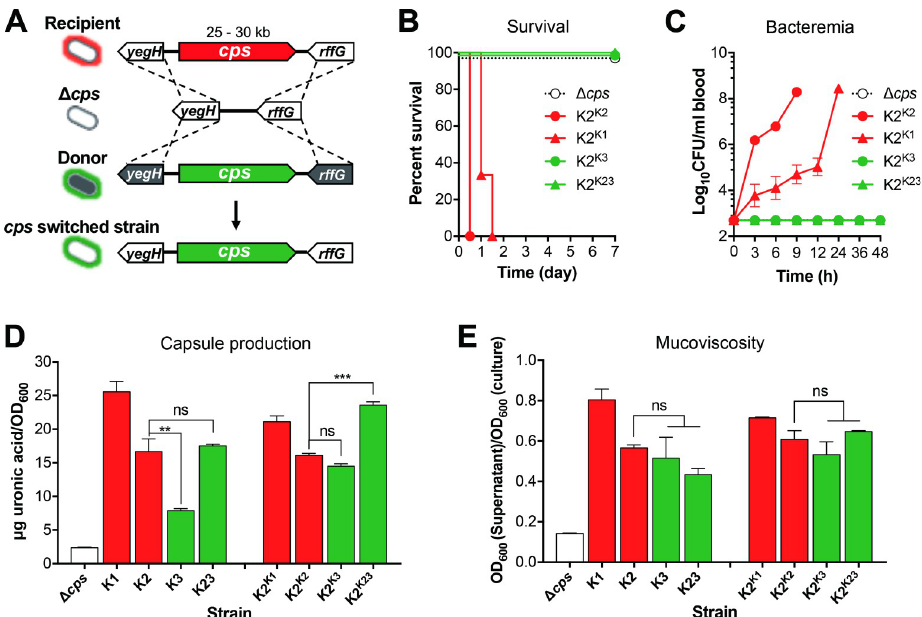
Fig 2. The role of capsule type in K . pneumoniae virulence. A. Schematic diagram of the capsule type replacement strategy in ATCC43816 (capsule type K2). The cps gene cluster of recipient strain (red region) was first deleted to produce an unencapsulated ( Δ cps ) mutant before the cps gene amplicon (green region) of donor strain were transformed into the Δ cps strain to yield capsule replacement strain. B, C. Virulence traits of K2 derivatives. CD1 mice were i.p. infected with 10 6 CFU of acapsular mutant of ATCC43816 ( Δ cps ) or isogenic derivative carrying the cps gene cluster of capsule type K1 from strain TH12908 (K2 K1 ), K2 from ATCC43816 (K2 K2 ), K3 from ATCC13883 (K2 K3 ), and K23 from TH12852 (K2 K23 ) to determine survival rate ( B ) and bacteremia level ( C ). Dash line denotes the detection limit. n = 6. D, E . Quantification of capsule production ( D ) and mucoviscosity ( E ) of the recipient strain (K2), acapsular mutant ( Δ cps ), capsule switched variants (hybrids) and respective cps donor strains (donor). The capsular polysaccharide (CPS) was quantified by the uronic acid method and presented as the amount of uronic acid per OD 600 . Mucoviscosity status was evaluated by the sedimentation assay and shown as the OD 600 ratio of the supernatant and culture. The data were pooled from two independent experiments and presented as mean ± SD, and statistically tested with one-way ANOVA with Tukey’s multiple comparisons. ns, not significant; �� , P < 0.01; ��� , P < 0.001. also displayed significant difference in the amount of CPSs with a high-to-low order of K2 K23 , K2 K1 , and K2 K3 , suggesting the differential impact of genetic background on the production of various capsule types. However, the K23 hybrid (K2 K23 ) still retained the low-virulence pheno- type as the donor strain (K23). The result shows that capsule type defines K . pneumoniae viru- lence phenotype. In the context of virulence phenotypes, we compared the isogenic K2 derivatives in colony mucoviscosity. The string test result showed the same mucoviscosity phenotypes between the K2 hybrid strains of K1 (K2 K1 ), K2 (K2 K2 ) and K3 (K2 K3 ), and the donor strains/capsule types ( Table 1 ). Specifically, complementation of Δ cps with the cps genes of the hypermucoviscous K2 strain yielded K2 K2 hybrid with hypermucoviscous colonies, whereas the K1 (K2 K1 ) and K3 (K2 K3 ) retained the non-hypermucoviscosity phenotype of the donor strains/type. Surpris- ingly, transformation of Δ cps with the K23 cps genes of a non-hypermucoviscosity strain gen- erated the hybrid strain with hypermucoviscous colonies. This result suggests that hypermucoviscosity represents a collective trait of genetic background and capsule type. Quantification of mucoviscosity by centrifugation revealed significant variations among the K . pneumoniae strains, but the data did not full recapitulate their string test levels or virulence phenotypes ( Fig 2E ). The K2 and K23 wild type and hybrid strains showed the same